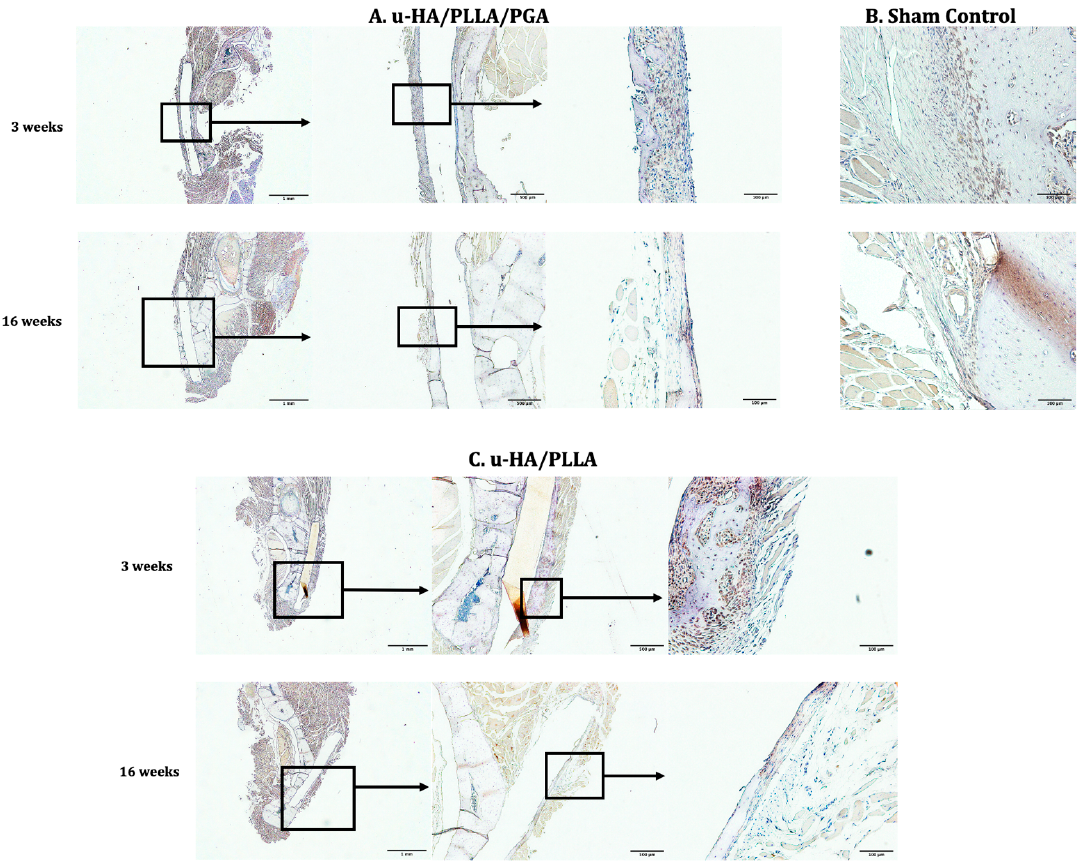
Figure 8. Runx2 expression in the u-HA/PLLA/PGA subgroup, u-HA/PLLA subgroup, and sham control. Images in each subgroup were taken at 1.25×, 4×, and 20× magnification (from left to right). Images of the sham control group were taken at 20× magnification. ( A ) u-HA/PLLA/PGA subgroup. ( B ) Sham control group. ( C ) u-HA/PLLA subgroup. Scale bar: 1 mm (1.25× magnification), 500 μ m (4× magnification), and 100 μ m (20× magnification). The above observations corresponded with the results of the Runx2 labeling index. All results indicate a significant decrease in the Runx2 labeling index from Week 3 to Week 16 in both material subgroups ( p < 0.05). However, the Runx2 labeling index did not differ between the two subgroups at any time point (p > 0.05) (Figure 9).